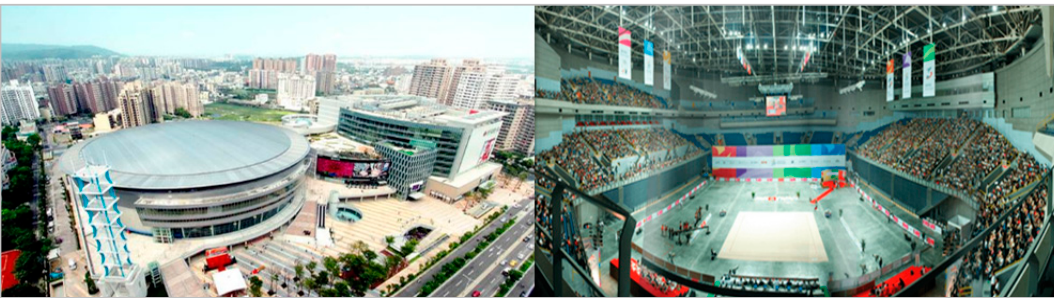
Figure 6. Kaohsiung Dome Building. (Open Source: Kaohsiung Dome official website [22]).